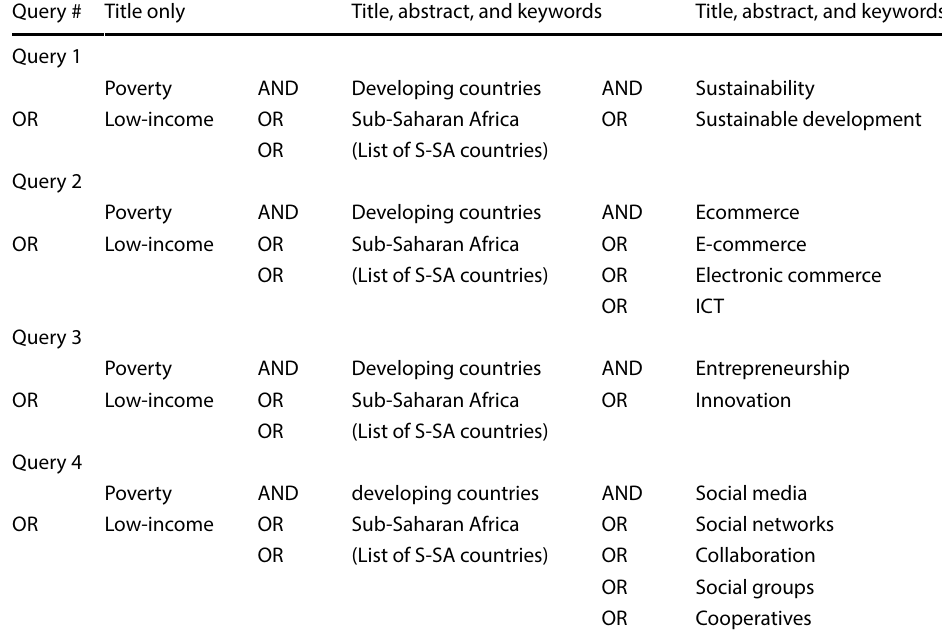
Table 1 Database